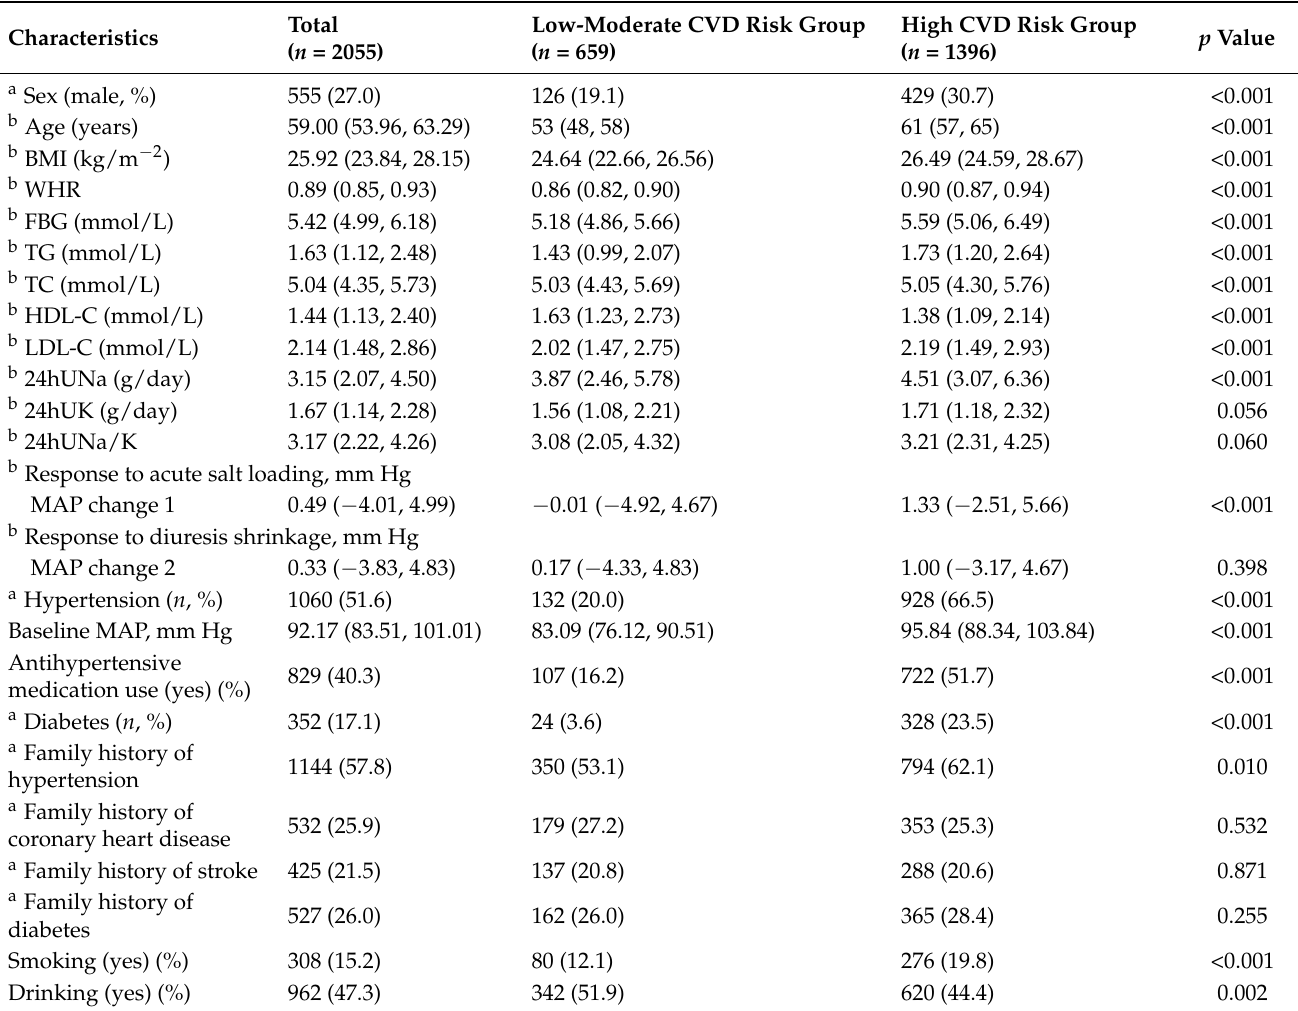
Table 1. Subject demographics based on salt